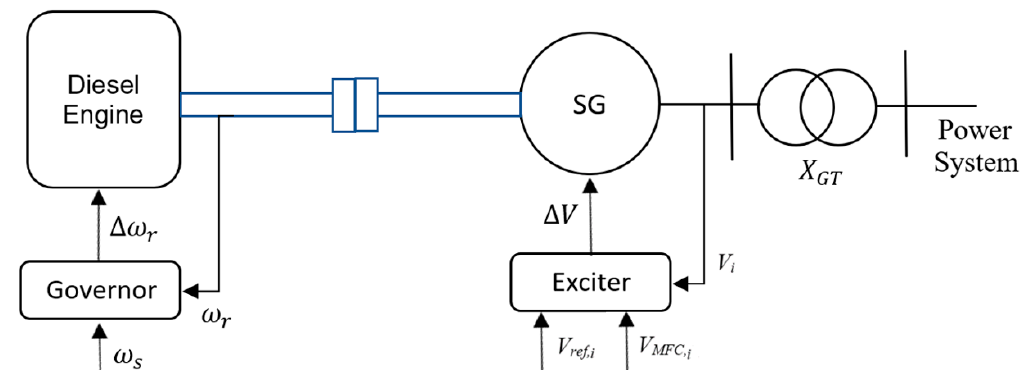
Figure 7. An SG utilizing an exciter and a governor.